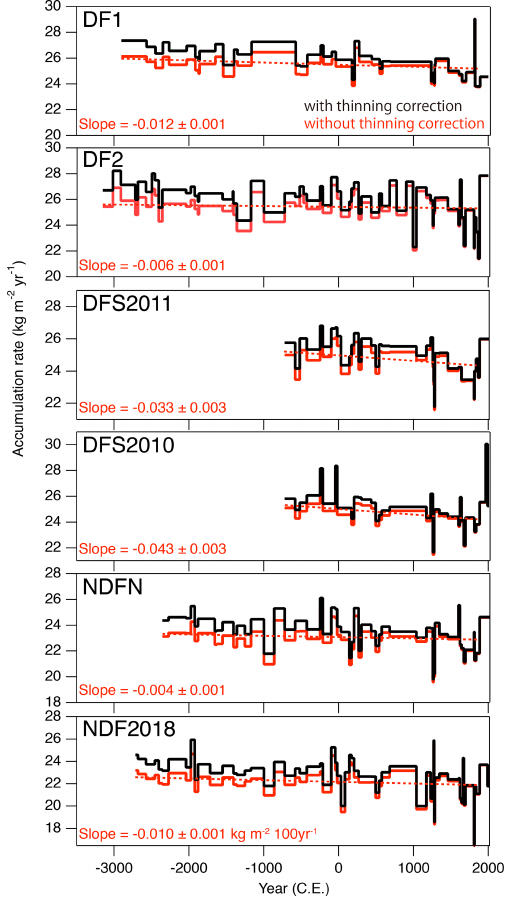
Figure 11. Temporal changes in accumulation rate with and with- out thinning correction. Statistically significant slope values from the results without thinning correction are